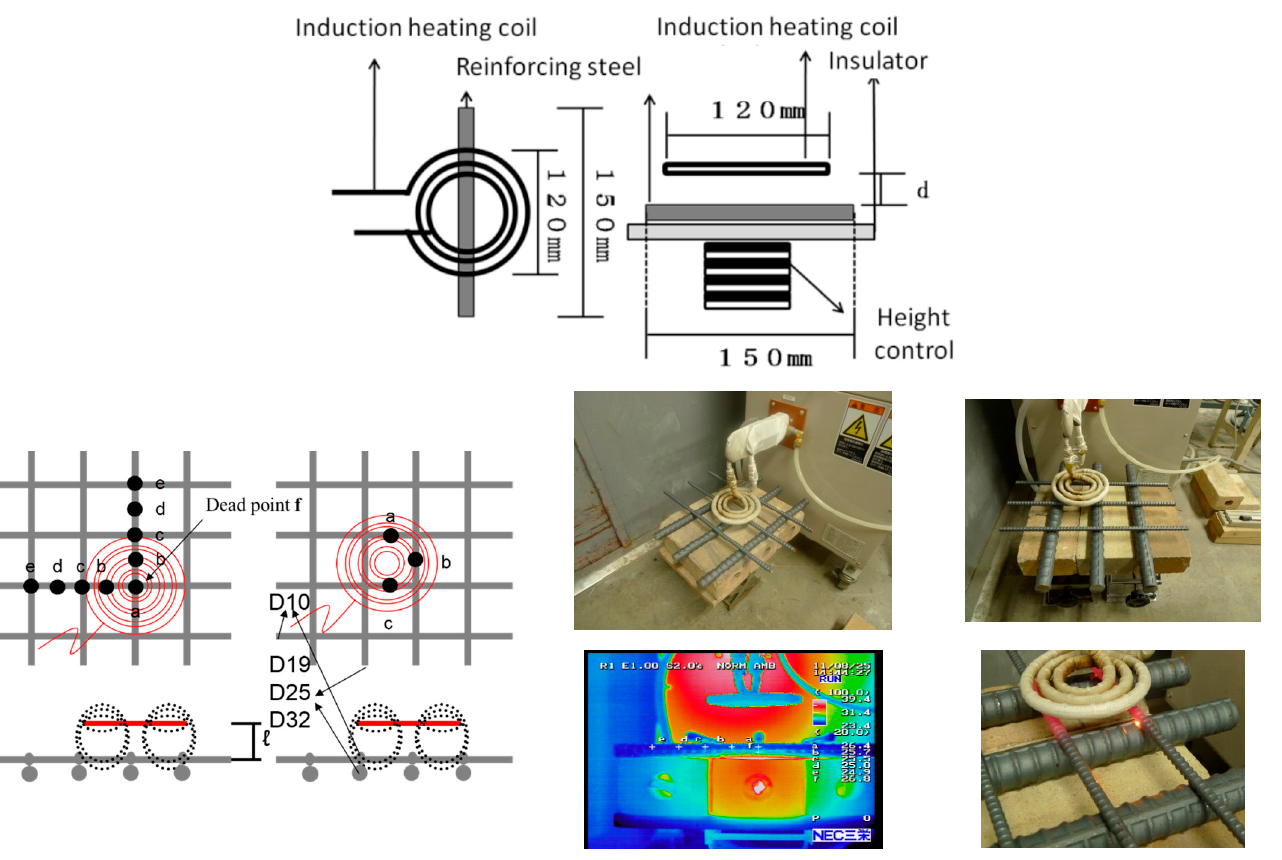
Figure 12. Thermal experiment method for crossed reinforcing bar.